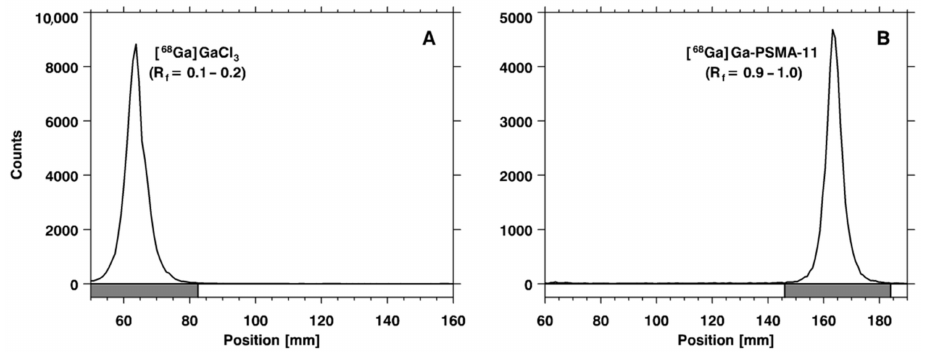
Figure 1. Chromatograms obtained using instant thin layer chromatographic (iTLC) glass microfiber impregnated with silica gel (SG)—iTLC-SG—and 0.1 M NH4OAc solution/MeOH (1:1) as an eluent: ( A ) [68Ga]GaCl3 and ( B ) [68Ga]Ga-PSMA-11. Rf: retention